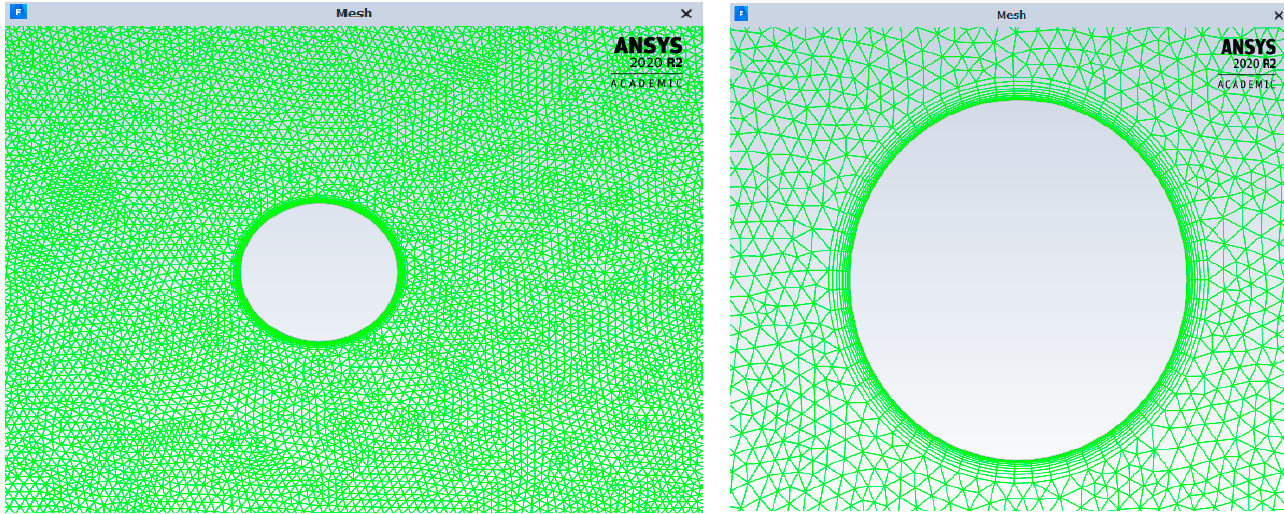
Figure 6. Mesh details showing two magnifications of the buoy model. Table 3. Mesh statistics for the CFD